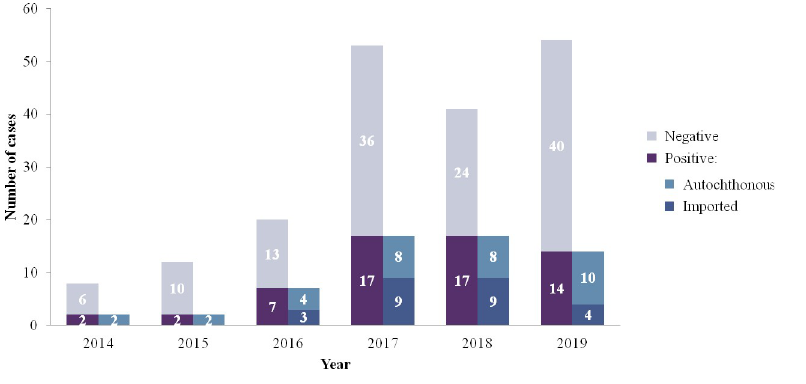
Fig 2. Distribution of CL cases from 2014 to 2019.